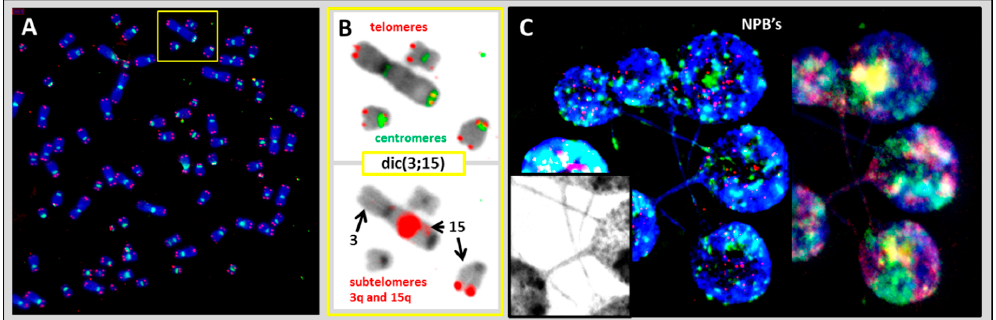
Figure 4. Clonal dicentric chromosome in the L428 cell line. ( A ) Telomere (red) and centromere (green) staining followed by ( B ) subtelomere staining of 3q (red) and 15q (red) demonstrated the presence of subtelomeric sequences in the breakpoint of this dicentric chromosome (100 × magnification). ( C ) Large nucleoplasmic bridge (NPB’s) with centromeric sequences were connected to the daughter cells even after four days of culture in the presence of cytochalasin B. M-FISH demonstrates the presence of chromosomes 3 and 15 in NPB’s (63 ×